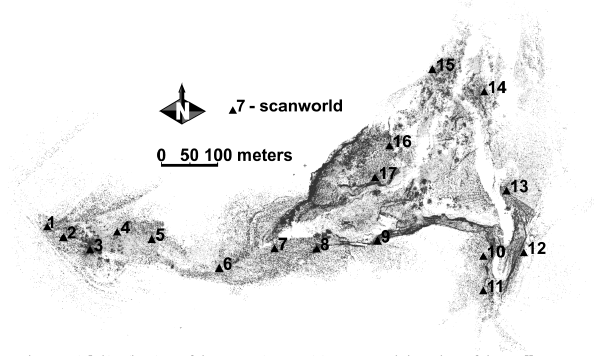
Fig. 3. The spatial distribution of the scanning positions around the edge of the gully